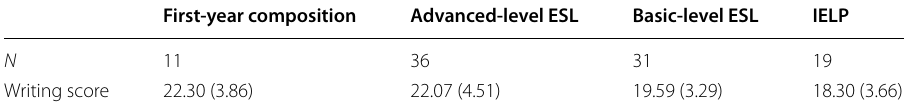
Table 1 The number of test-takers and average writing scores of TOEFL iBT ( SD s) across the four